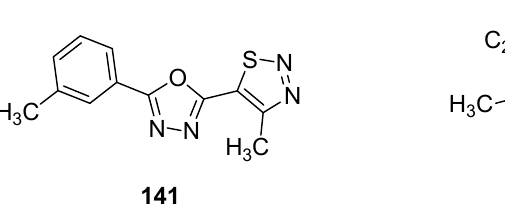
144143 Figure 28. Antifungal activity of triazole moiety containing 1,2,3-thiadiazolew 143–144 . Less antifungal activity was observed in the derivative 145 (Figure 29) reported by Tan et al. [155]. Its inhibition rates to Phytophthora infestans (Mont) de Bary, Alternaria solani , Gibberella sanbinetti , Physalospora piricola Nose, Botrytis cinerea , Phytophthora capsici Leonian, Cercospora arachidicola , Rhizoctonia solanii and Fusarium oxysporum reached 32.3, 17.4, 32.3, 25.8, 43.5%, 36.1, 15.8, 30.3 and 26.9% at 50 µg/mL respectively. The results in- dicated that the structural motif 145 proved to be broad-spectrum fungicide because it exhibited significant antifungal activity against different fungal strains [155].